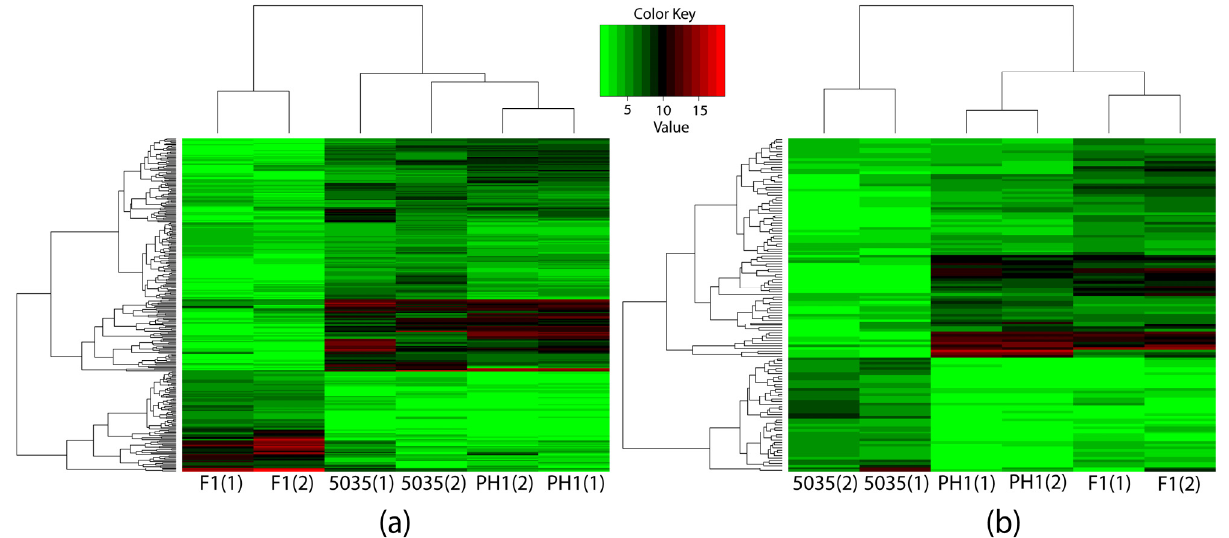
Figure 3. Three strains were clustered by expressions of identified DEGs through hierarchy clustering. The horizontal axis indicates the strains, and the numbers in parentheses represent different samples of the same strain. The vertical axis indicates the DEGs, the names of which are not shown in the figure. The expressions of the 296 DEGs identified through comparing different-productivity strains are shown in ( a ), while the 131 DEGs identified in the different-trichothecene-productivity group are shown in ( b ).